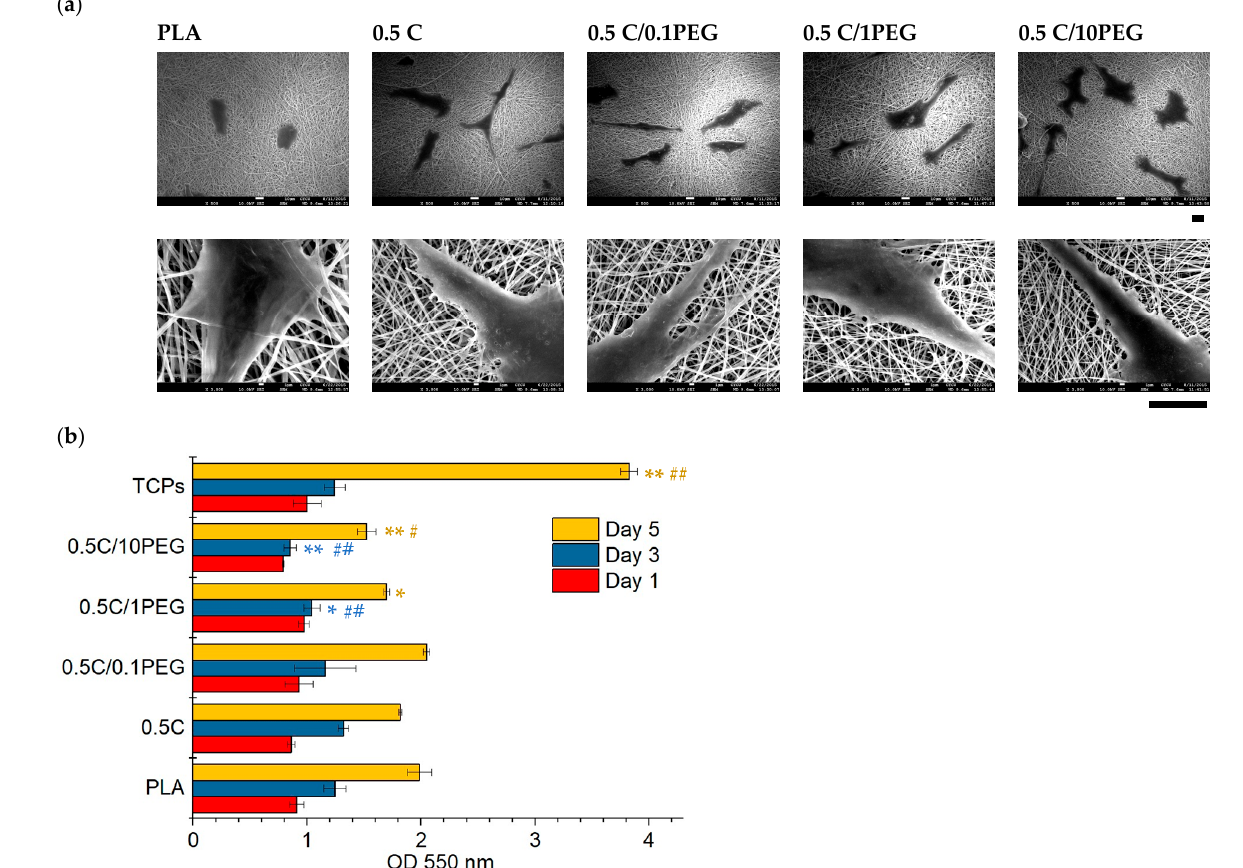
Figure 5. Cell adhesion and proliferation on nanofibers. ( a ) The rBMSCs were seeded to nanofibers for 3 days, and their morphology was examined by SEM. The top and bottom are low-magnification and high-magnification images, respectively. (scale bars = 10 μ m). ( b ) The MTT results of cells grown on nanofibers for 1, 3, and 5 days. (*: p < 0.05, **: p < 0.01 compared to the pristine PLA group; #: p < 0.05, ##: p < 0.01 compared to the 0.5 C group).